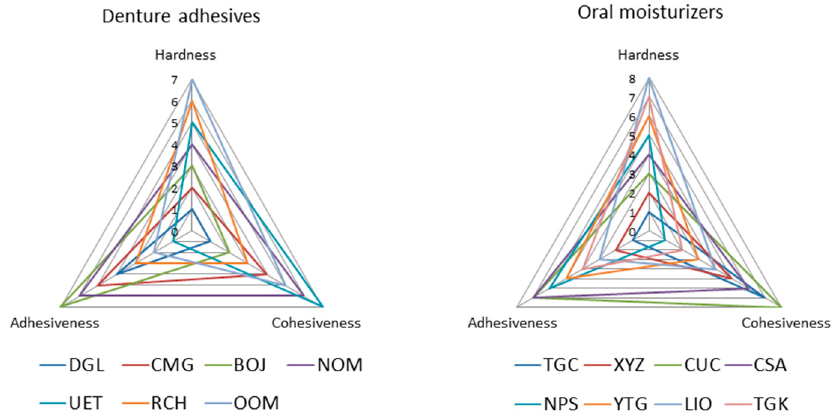
Figure 6. Radar charts with three axes ( Left : denture adhesives; Right : oral moisturizers).